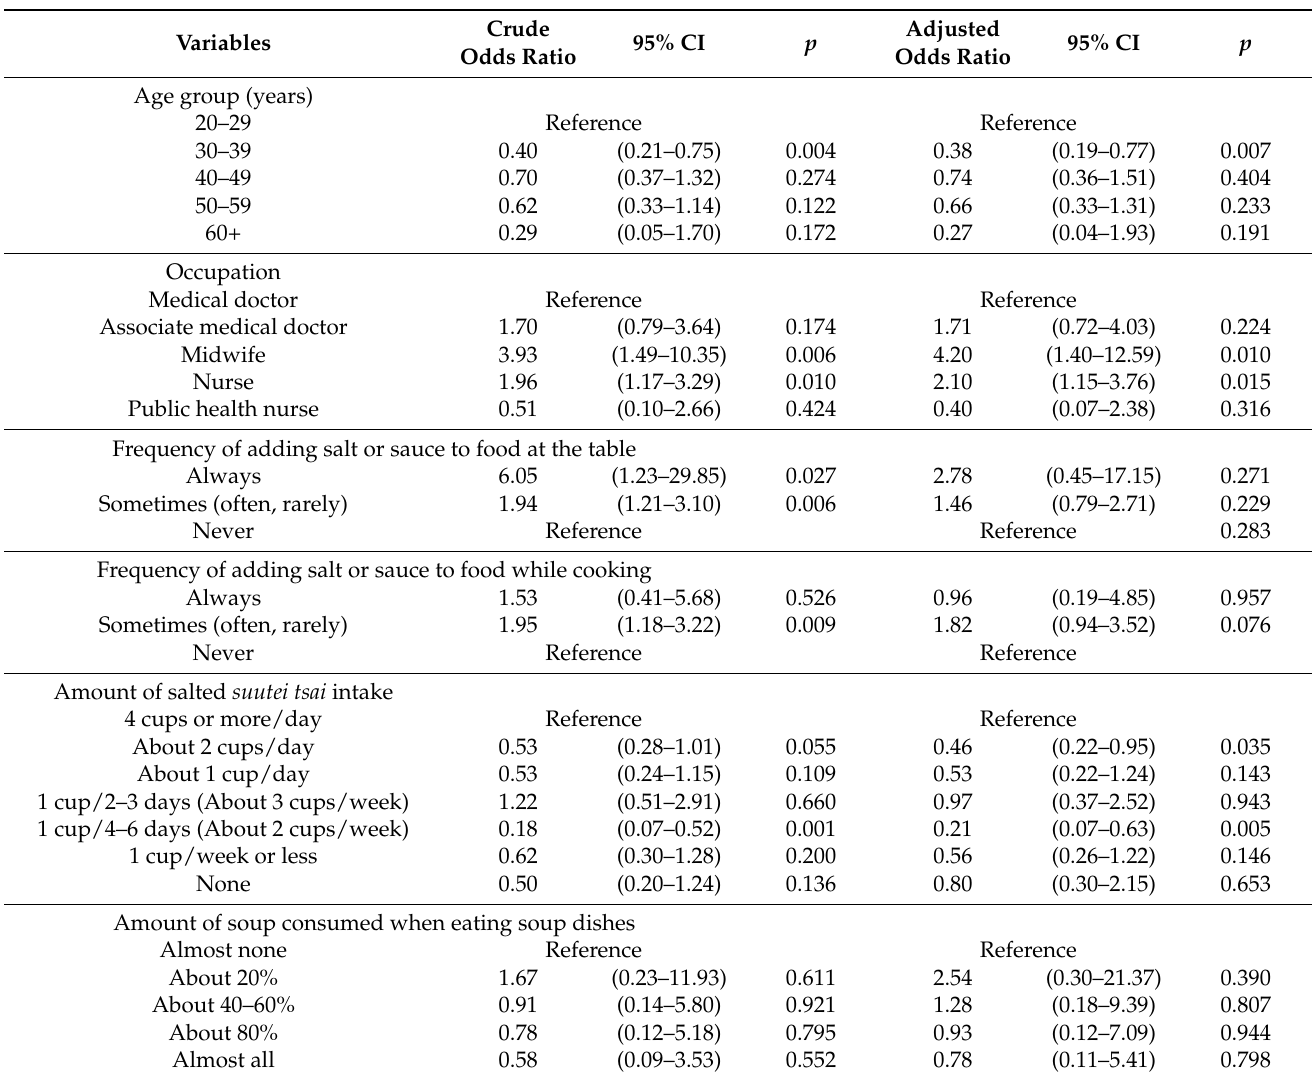
Table 3. Factors related to lacking knowledge on the recommended daily salt